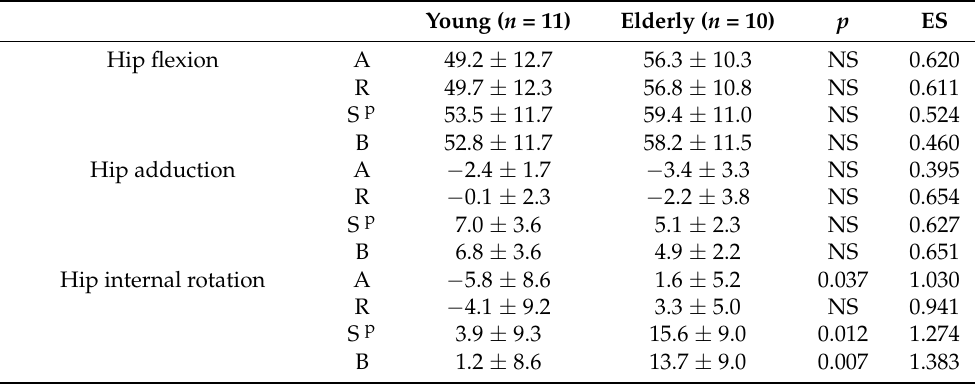
Figure 4. Kinematic data of one case of braking action in each group. Table 4. Joint angle during emergency